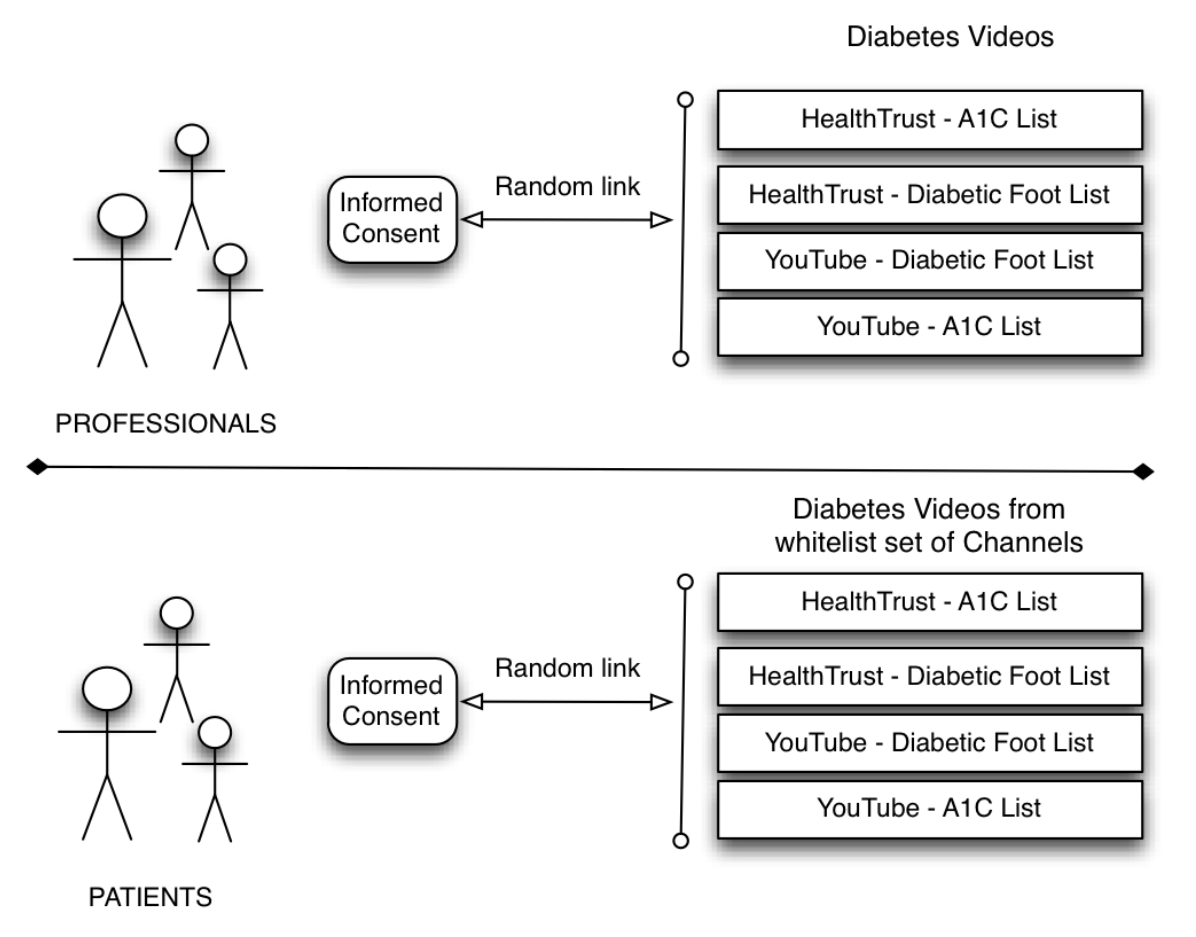
Figure 9. Process of obtaining informed consent from health care professionals and health consumers, and survey